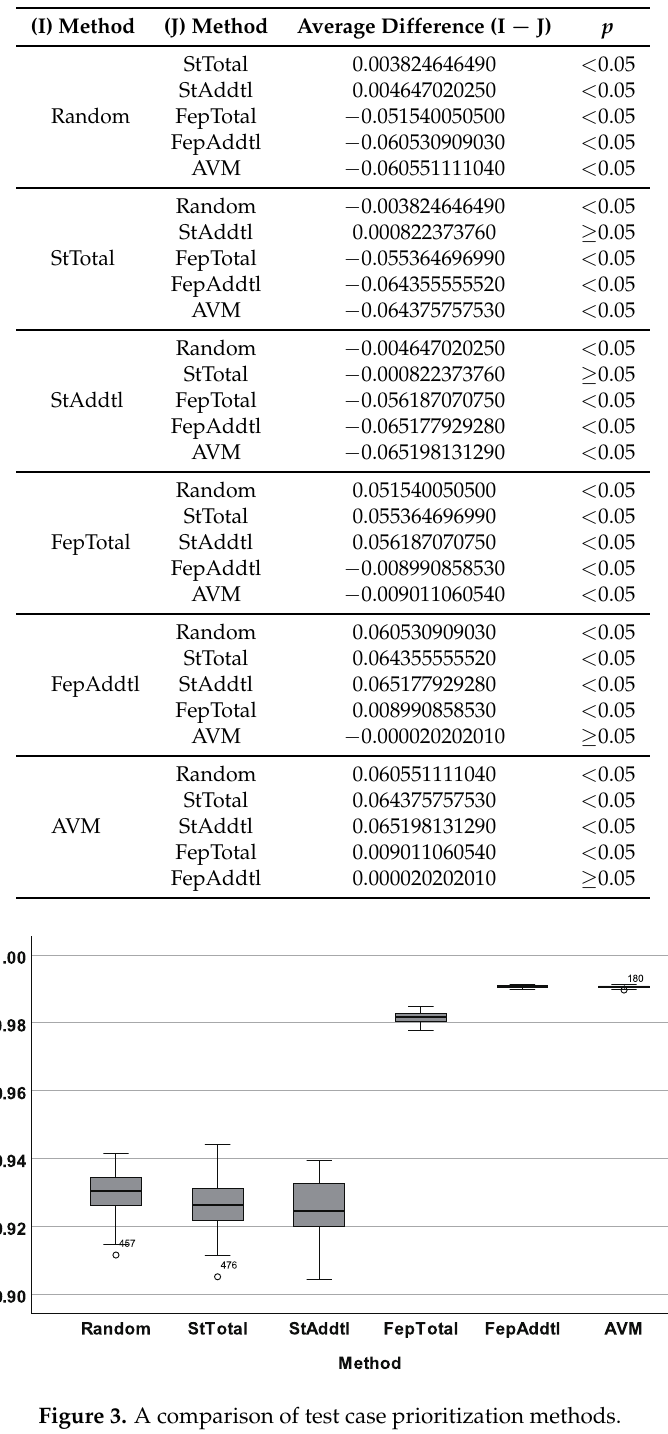
Table 3. The outcomes of test case prioritizations.